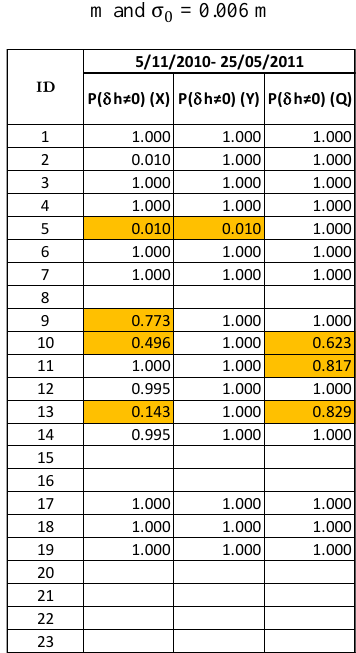
Table 10. Results of Bayesian analysis with prior data μ = 0.005